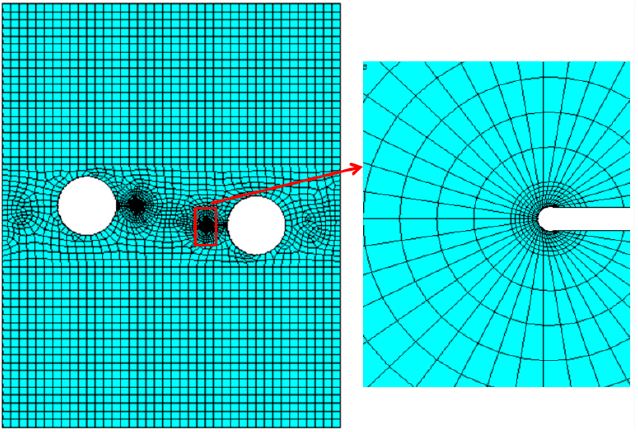
Figure 3. Geometry of a plate with two non-collinear through cracks.